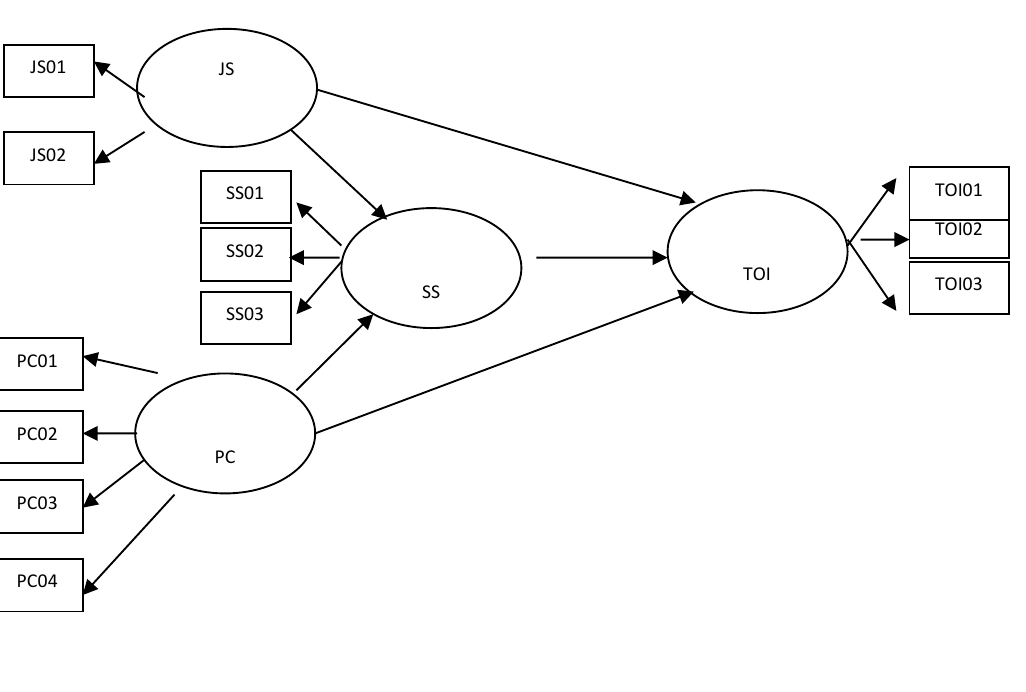
Figure 1: The Research Model